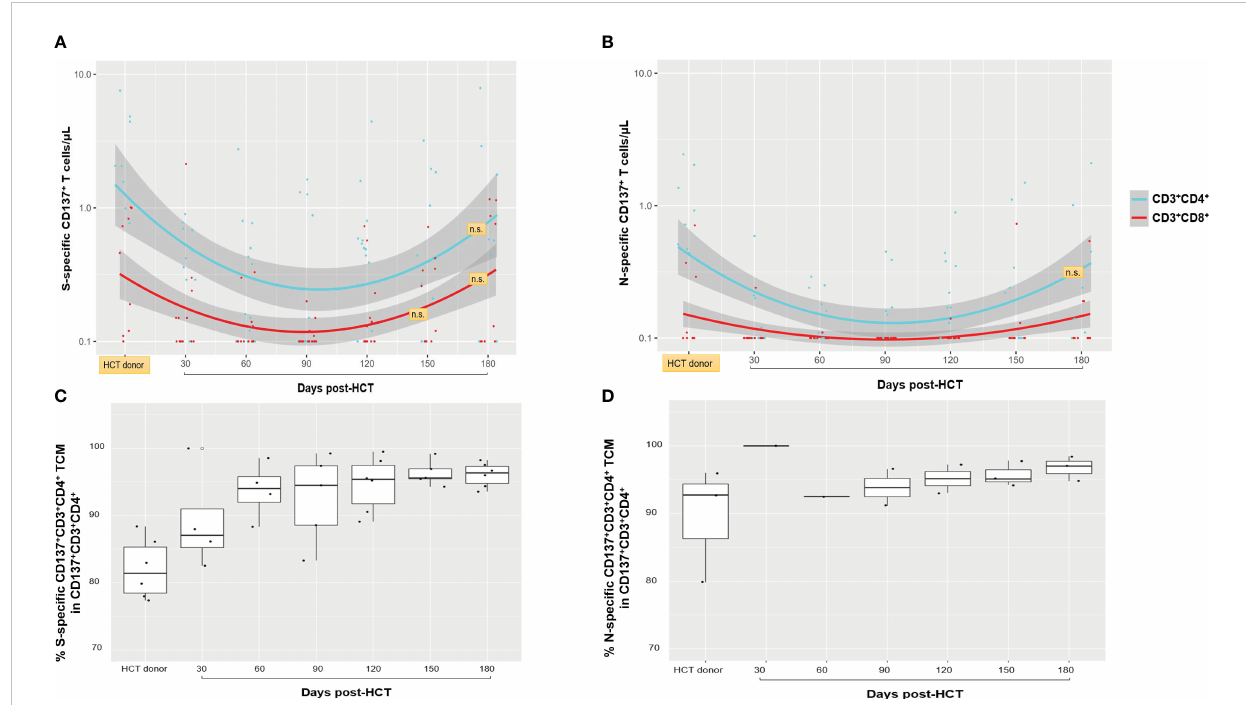
analogous to S-speci fi c IFN- g . levels (Figure 2 lower left plot) and N-speci fi c IFN- g versus CD137 + T-cell levels (Figure 2 lower middle plot) revealed a highly signi fi cant association between measurements ( p < 0.0001 for both S- and N-speci fi c responses). The lower right panel of Figure 2 details Spearman ’ s correlation coef fi cients and p -values calculated and plotted as matrices. The strong correlation of outcomes suggests that functionally active SARS-CoV-2-speci fi c CD137 + T cells consistently displayed an IFN- g Th1 response.